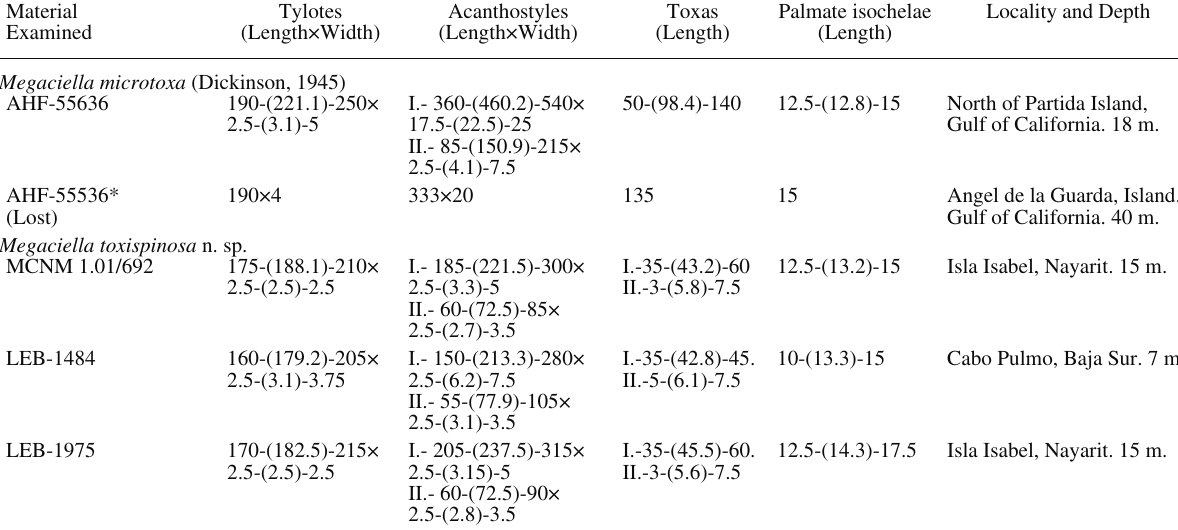
Table 5. – Comparative table data of spicule categories for the Megaciella species from the Mexican Pacific. Values are expressed in minimum-average-maximum (μm).* Spicules measurements from the original description. Material